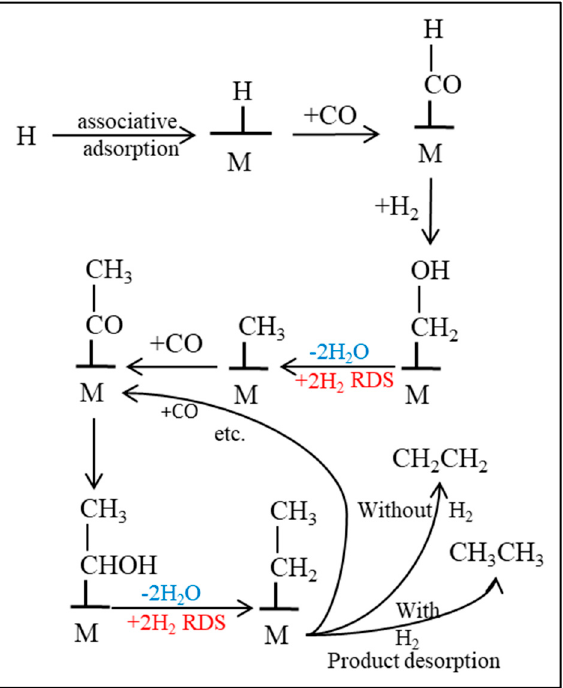
Figure 5. A proposed FTS route based on the CO insertion mechanism.